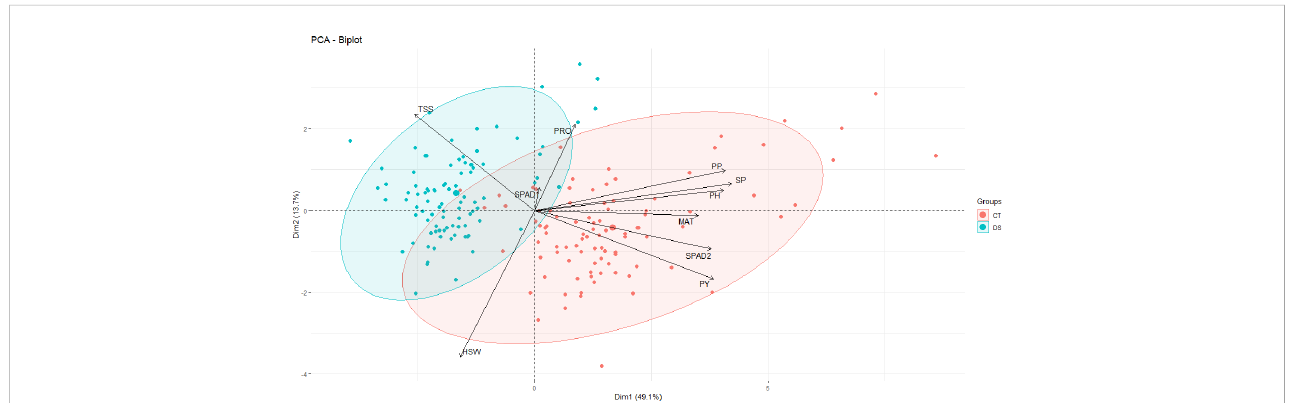
FIGURE 4 PCA biplot showing the clustering of 93 faba bean accessions grown under control and drought stress conditions based on the variance in 10 morpho- physiological and biochemical traits. The traits are maturity date (MAT), plant height (PH), number of pods per plant (PP), number of seeds per plant (SP), 100 seed weight (HSW) and plot yield (PY), free proline content (PRO), total content of soluble sugars (TSS) chlorophyll content (SPAD1 and SPAD2). The fi rst two components explained 49.3% and 18% of the variances, respectively. The magnitude of the vectors (arrows) shows the strength of their contribution to each PC. Vectors pointing in similar directions indicate positively correlated variables, vectors pointing in opposite directions indicate negatively correlated variables, and vectors at proximately right angles indicate low or no correlation. Colored concentration ellipses (size determined by a 0.95-probability level) show the observations grouped by treatment (control or drought conditions). Individuals on the same side as a given variable should be interpreted as having a high contribution on it.